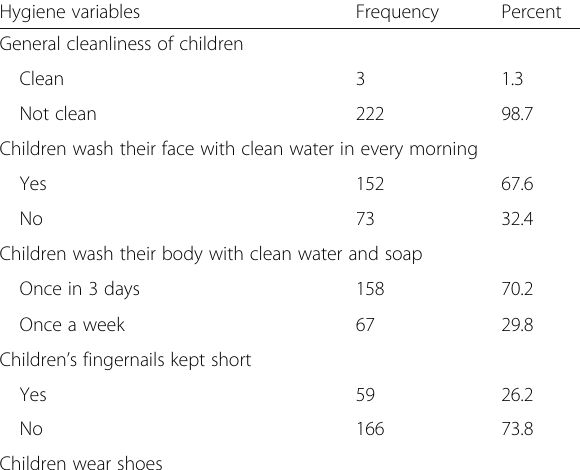
Table 2 Personal hygiene of children aged 6 – 59 months in rural Dembiya, northwest Ethiopia, May 2017 Hygiene